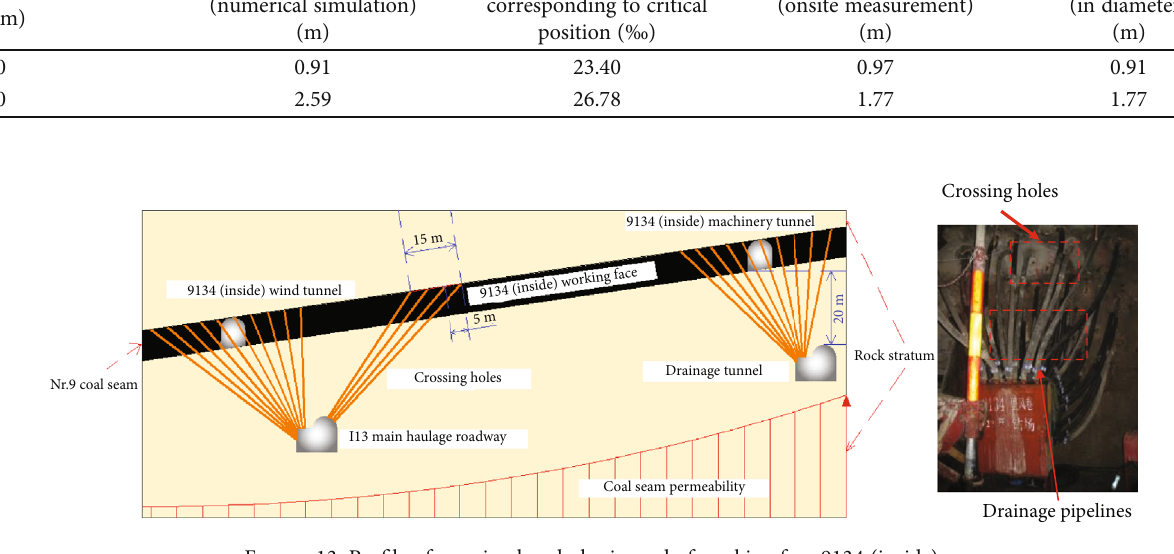
Figure 13: Pro fi le of crossing boreholes in coal of working face 9134